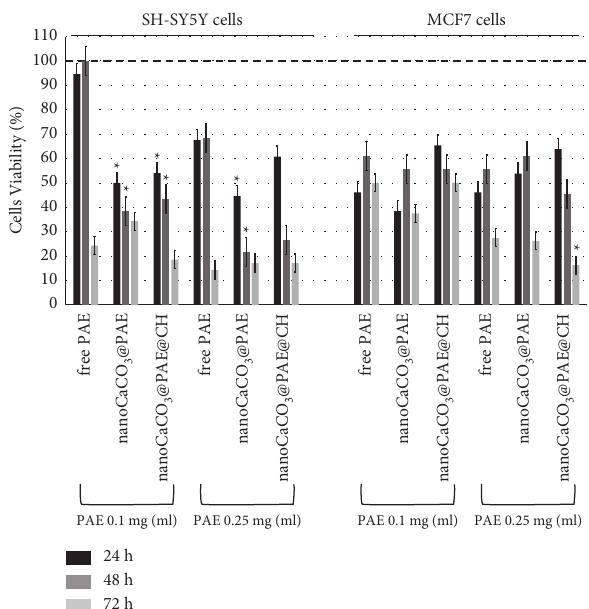
Figure 8: Cells viability by MTTtests for SH-SY5Y and MCF7 cells after 24-48-72h of treatment with nanoCaCO PAE, and nanoCaCO 3 @PAE@CH at different concentrations. Percentage viability data referred to respective not treated control condition at each time point (100%, indicated by dashed line). Values represent mean from three independent experiments. Statistically significant value ∗ P ≤ 0 . 05 is with respect to free PAE condition, from the t